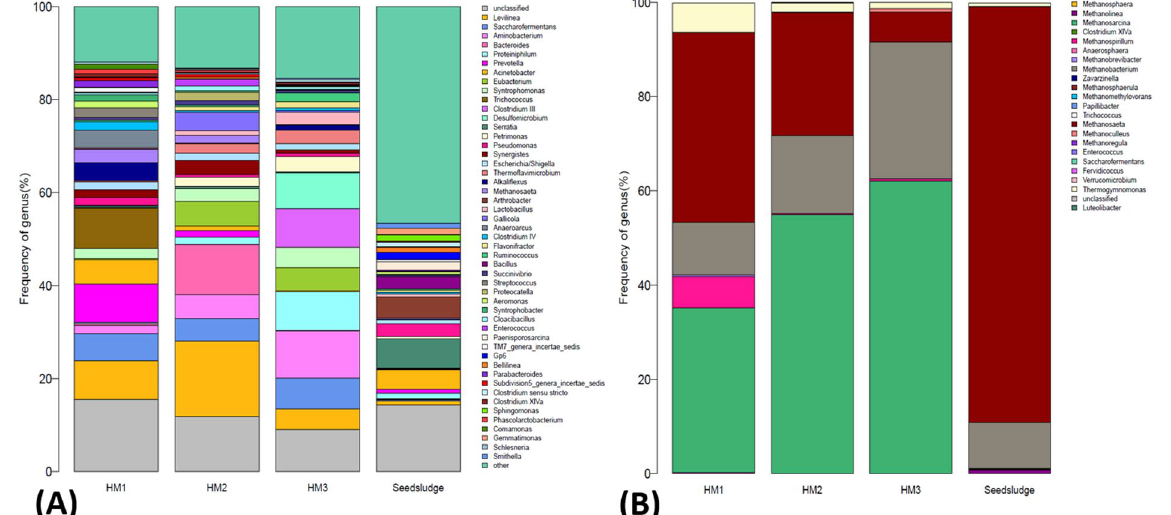
Figure 3. ( A ) Taxonomic classification of the dominant phylogenetic groups from HM1, HM2, HM3 and Seed sludge at the genus levels, ( B ) Taxonomic classification of the dominant archaeal groups from HM1, HM2, HM3 and Seed sludge at the genus